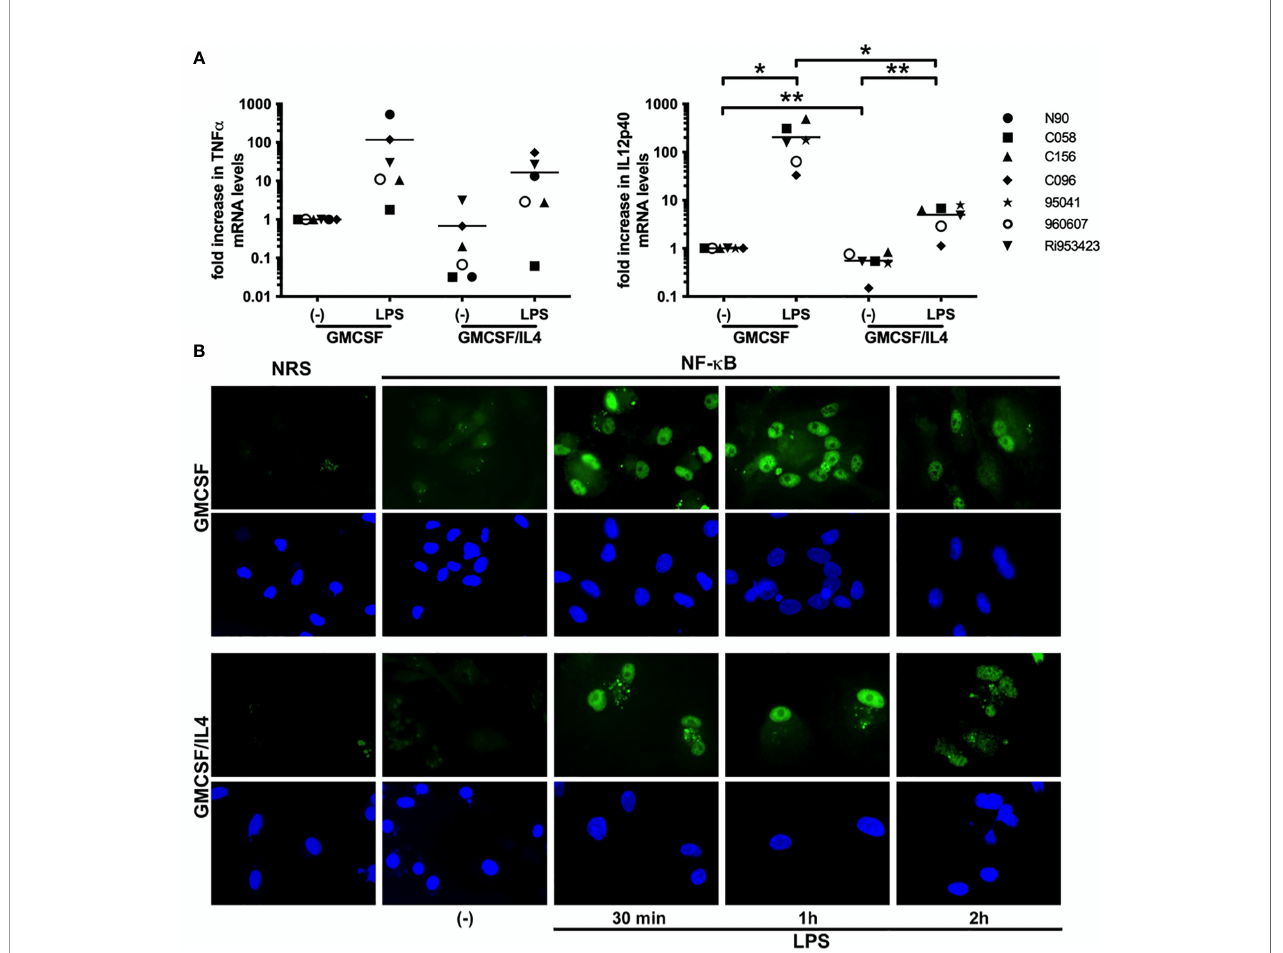
FIGURE 4 | LPS-induced cytokines are impaired at the transcriptional level, but NF- k B translocalization is intact. (A) TNF a and IL-12p40-encoding mRNA expression levels in GMCSF and GMCSF/IL-4-exposed microglia stimulated with 500 ng LPS/ml for 16h were quanti fi ed by real time RT-PCR. mRNA levels are expressed relative to GAPDH mRNA expression levels, *p < 0.05 **p < 0.01 paired t-test. Different symbols represent different donors and horizontal lines indicate means. (B) NF- k B p65 (green) localization in microglia exposed to GMCSF or GMCSF/IL-4 stimulated with 500 ng LPS/ml for 30 min, 1h and 2h [ (B) , upper panels]. NRS, normal rabbit serum. Cell nuclei (blue) were visualized using 4 ’ , 6-diamidino-2-phenylindole (DAPI, lower panels). Original magni fi cations